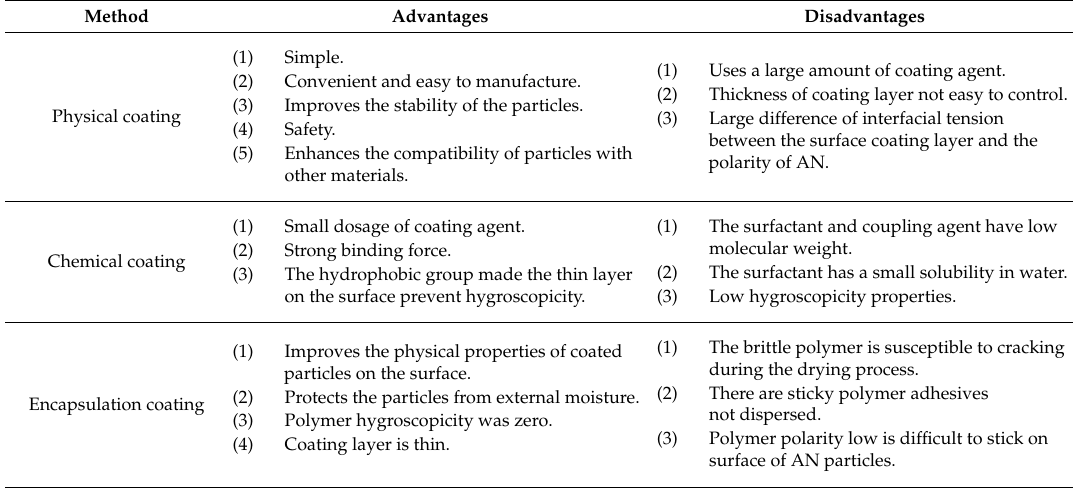
Table 4. Advantages and disadvantages of coating